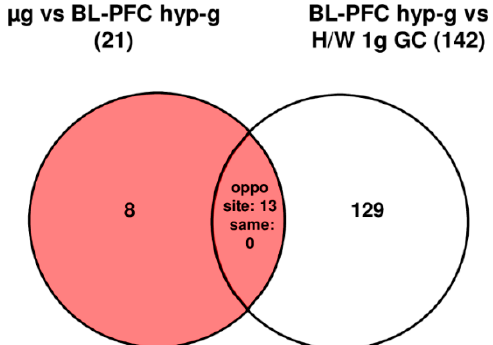
Figure 9. Strategy for the identification of hypergravity- and microgravity-sensitive probe sets in human